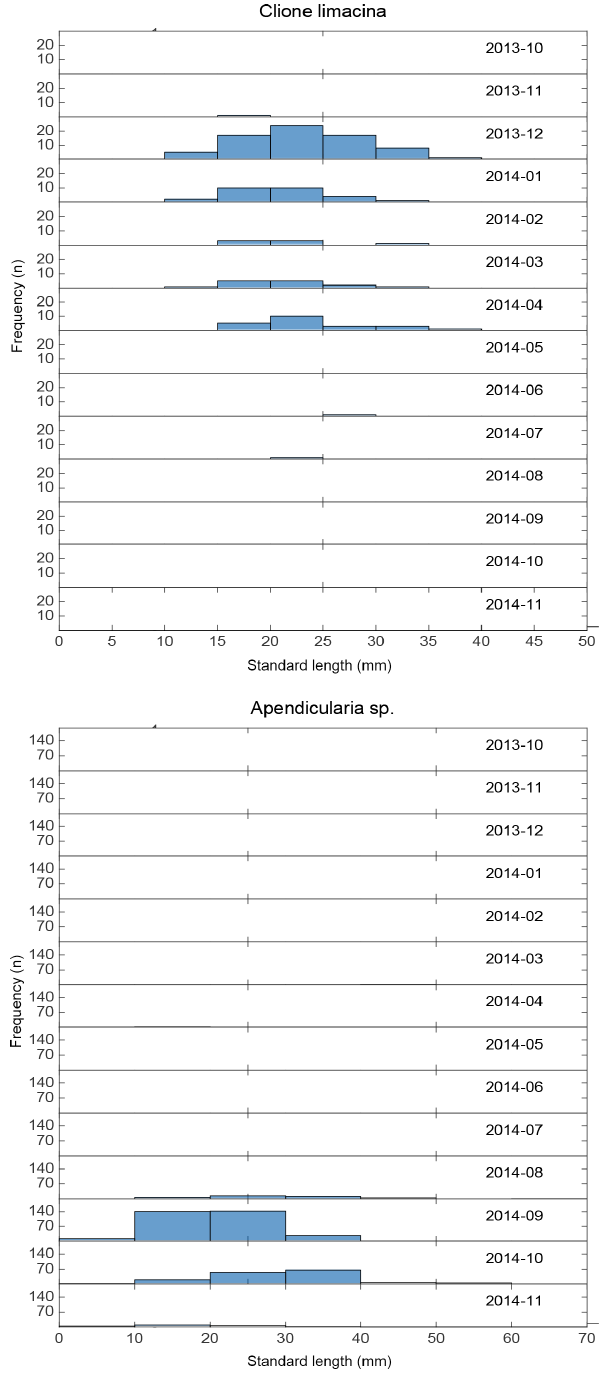
Figure 10. Length–frequency distributions of selected species (see panels) over the seasonal